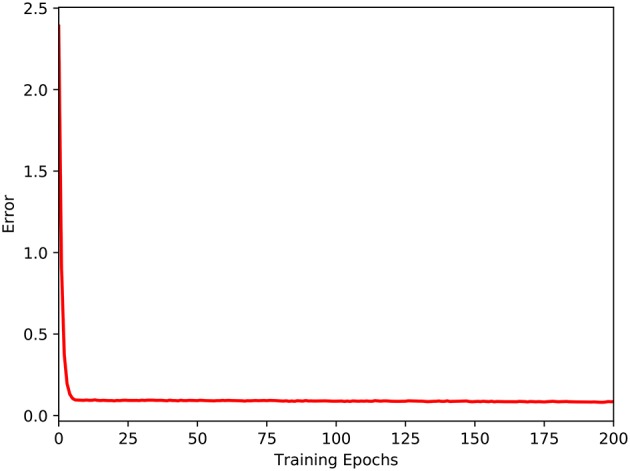
The training of the eye-mobile coordination network.